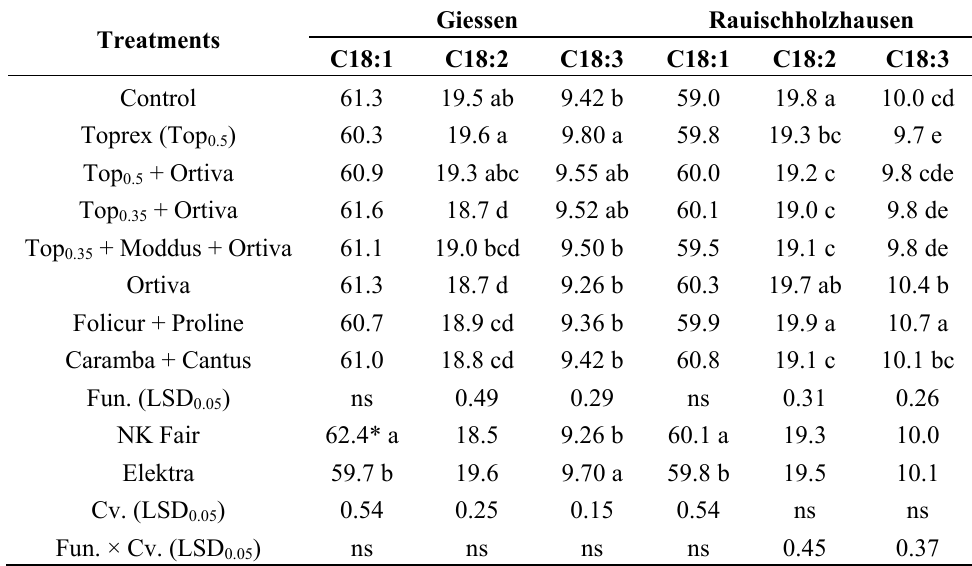
Table 5. Effect of fungicides and growth regulator on unsaturated fatty acids of two cultivars of winter rapeseed at GI and RH.